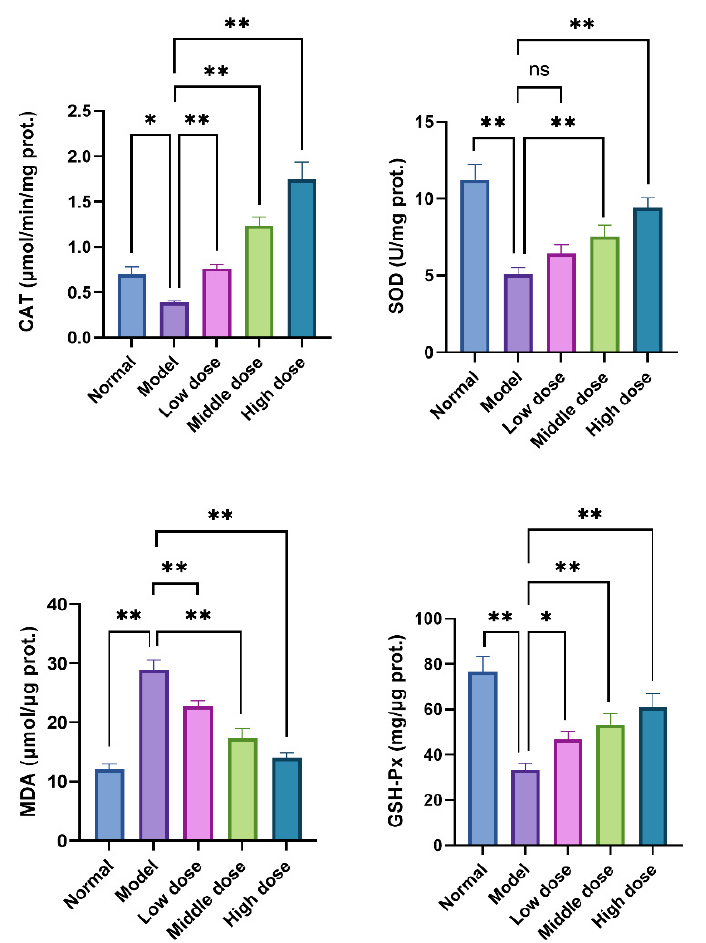
Figure 12. Effects of SMP on CAT, SOD, GSH-Px, and MDA in H 2 O 2 -stimulated PC12 cells. The levels of MDA and activities of CAT, SOD, and GSH-Px were determined by commercial assay kits. PC12 cells were treated with SMP (4%, 8%, and 16%) for 24 h and subsequently subjected to H 2 O 2 (100 µ M) for 24 h. SMP: Salvia miltiorrhiza-containing plasma; CAT, catalase; SOD: superoxide dismutase; MDA: malondialdehyde; GSH-Px: glutathione peroxidase. The values were represented as the mean ± SD ( n = 3). ns: no significant difference, * p < 0.05 and ** p < 0.01 vs. model group.